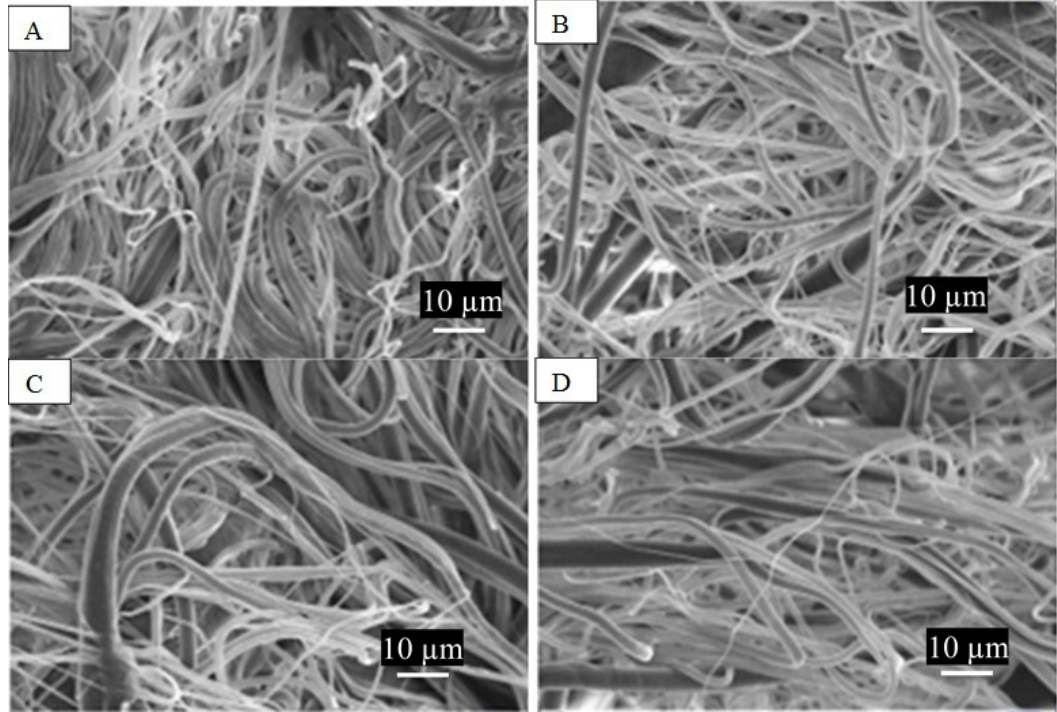
Figure 7. SEM images of PCL fibers prepared from 12.5 wt% PCL solutions in solvent ratios of 40:60 (DMF:THF) mixtures and at different rotational speeds. ( A ) DMF:THF (40:60) at 5000 rpm; ( B ) DMF:HF (40:60) at 6000 rpm; ( C ) DMF:THF (40:60) at 7000 rpm; ( D ) DMF:THF (40:60) at 8000 rpm.